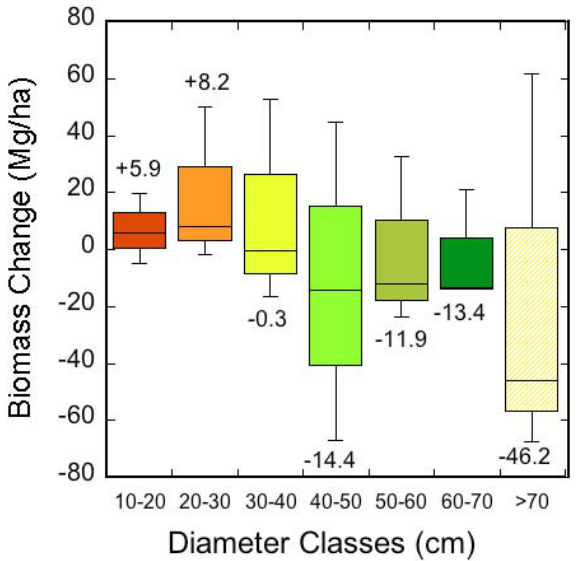
Fig. 11. Lidar-derived AGB range and AGB change (20m spatial scale). AGB in subplots with low biomass is increasing, while sub- plots with high biomass are losing biomass and contribute to the overall loss of biomass in